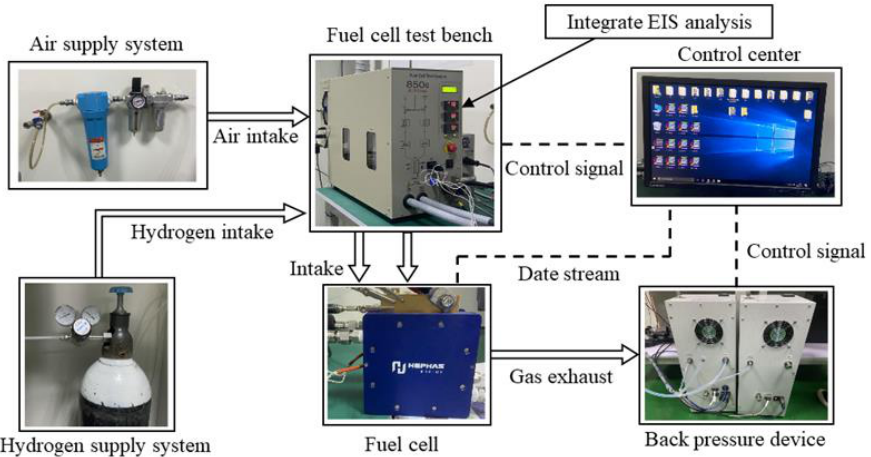
Figure 1. Connection diagram of the fuel cell test system.